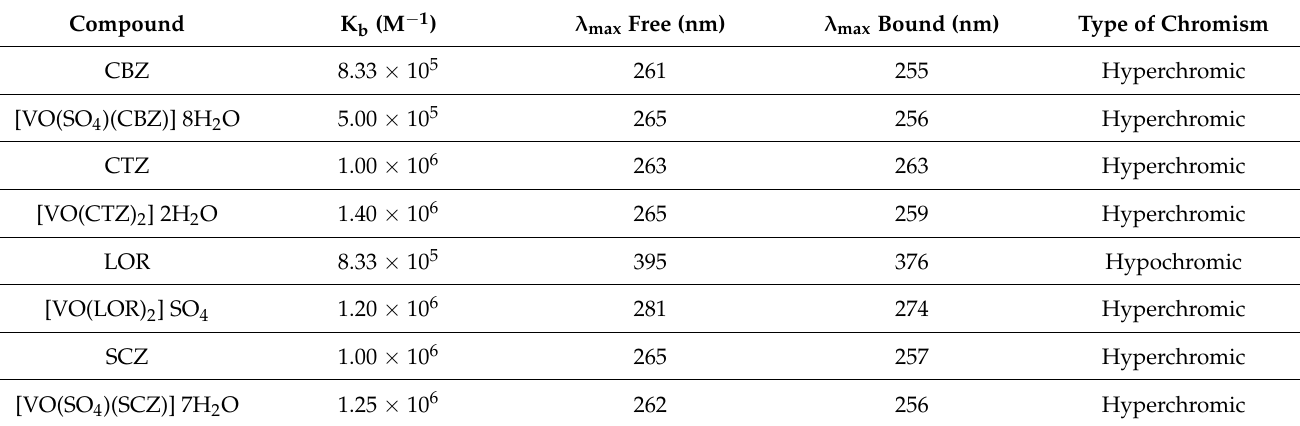
Table 8. The spectral parameters for the interaction of oxidovanadium(IV) complexes and their ligands with